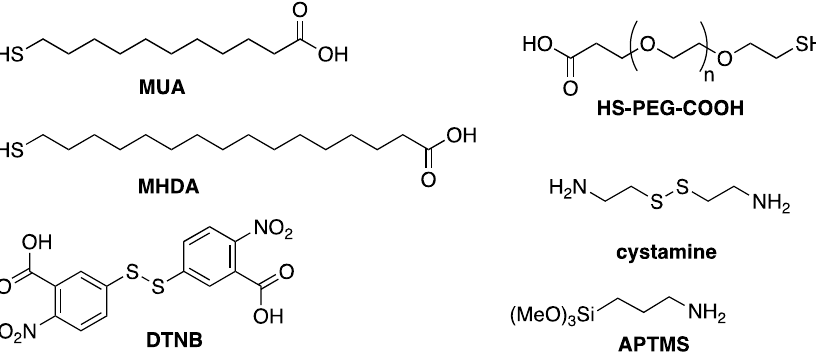
Figure 19. Bifunctional reagents for conjugation of bioreceptors to CTAB-capped AuNR and SiO 2 @AuNR.